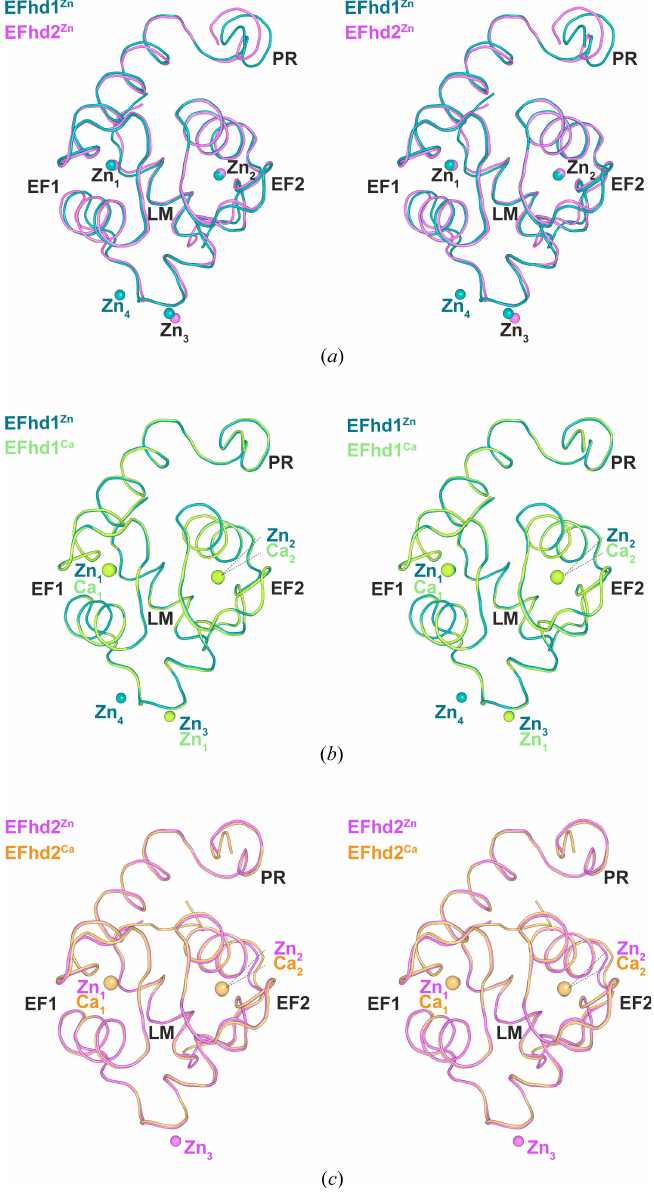
Figure 2 Superposition of overall structures of Ca 2+ - or Zn 2+ -bound EFhd1 and EFhd2. ( a )–( c ) Stereo diagrams of superimposed structures of EFhd1 and EFhd2 represented by ribbon diagrams. ( a ) Structural superposition of EFhd1 Zn in teal and EFhd2 Zn in magenta. ( b ) Structural superposition of EFhd1 Zn in teal and EFhd1 Ca in lime green. ( c ) Structural superposition of EFhd2 Zn in magenta and EFhd2 Ca in